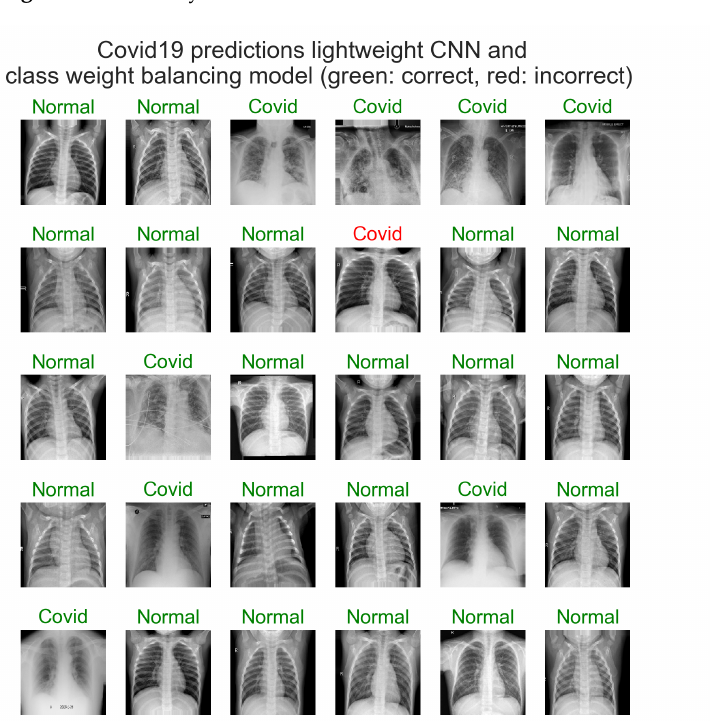
Figure 16. Accuracy function case 4 in Table 9.